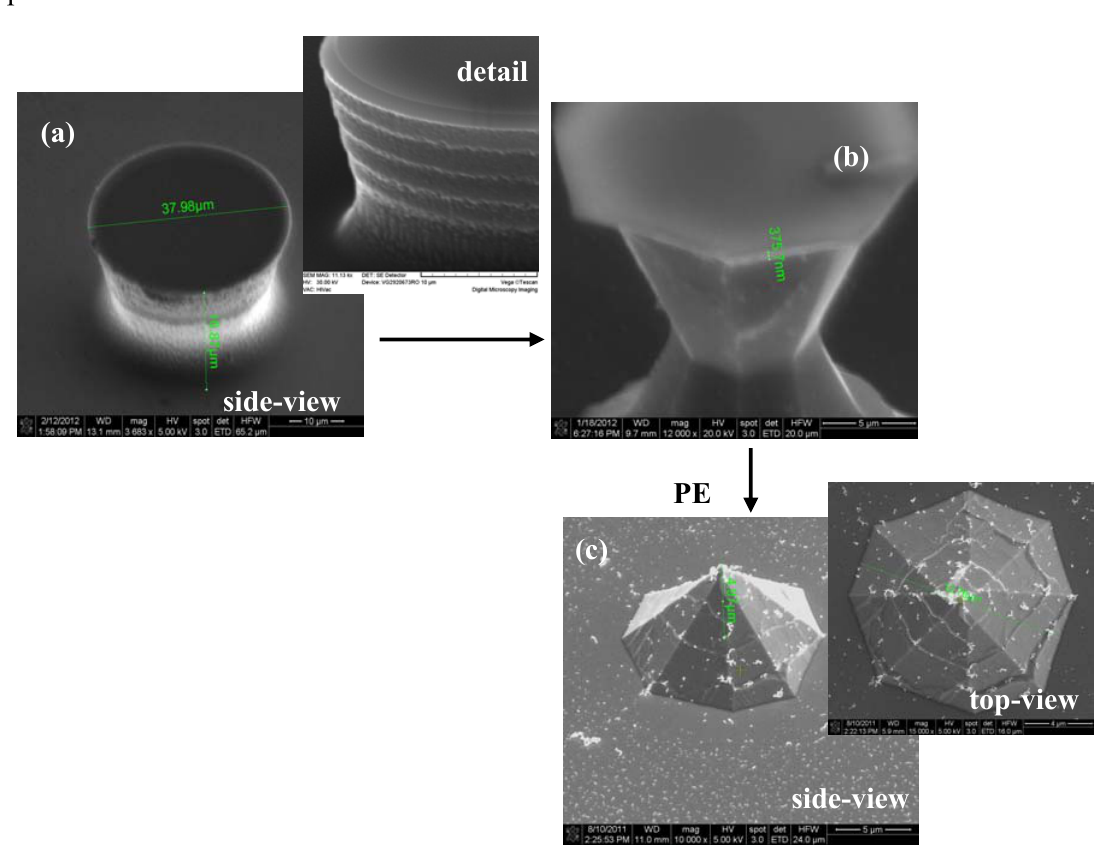
Figure 2. SEM images of an electrode subjected to dry ( a ) and anisotropic wet ( b ) etching